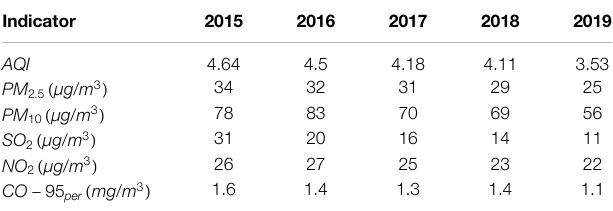
TABLE 3 | Air pollution data of Zhangjiakou. Indicator